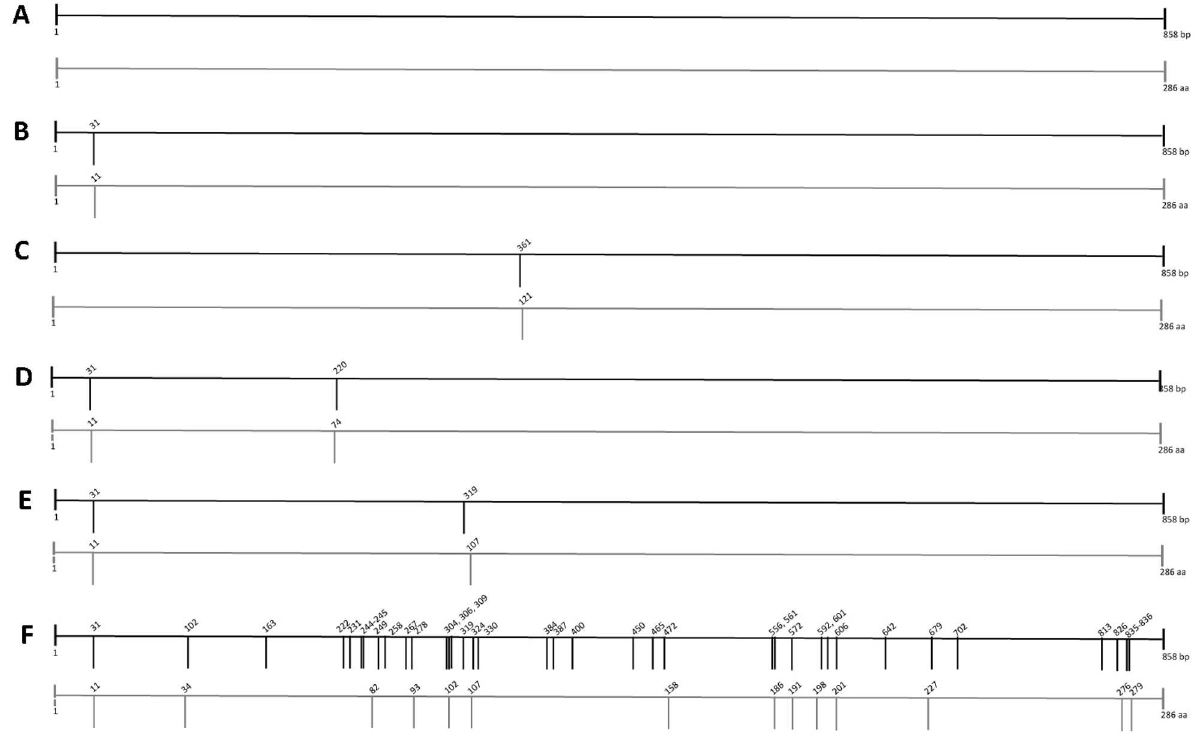
Fig 8. P . acnes CAMP factor 1 polymorphism. CAMP factor 1 nucleotide sequenceanalysiswas performedon the 27 P . acnes isolates, as describedin the Materials and Methods. Nucleotide (dark bold) and peptide(light gray) changesidentifiedin P . acnes isolates relative to the reference sequenceof the P . acnes NTCT 737 strain (GenBank accessionnumberAY527218.1) are indicatedby vertical bars. (A), (B and C), (D and E), (F) correspondto CAMP1 with no, 1, 2, and several mutations, respectively.See also Table 4.